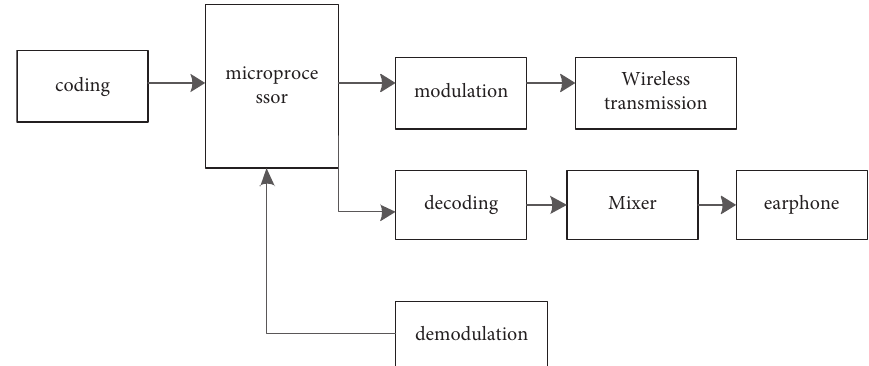
Figure 4: Block diagram of chairman machine